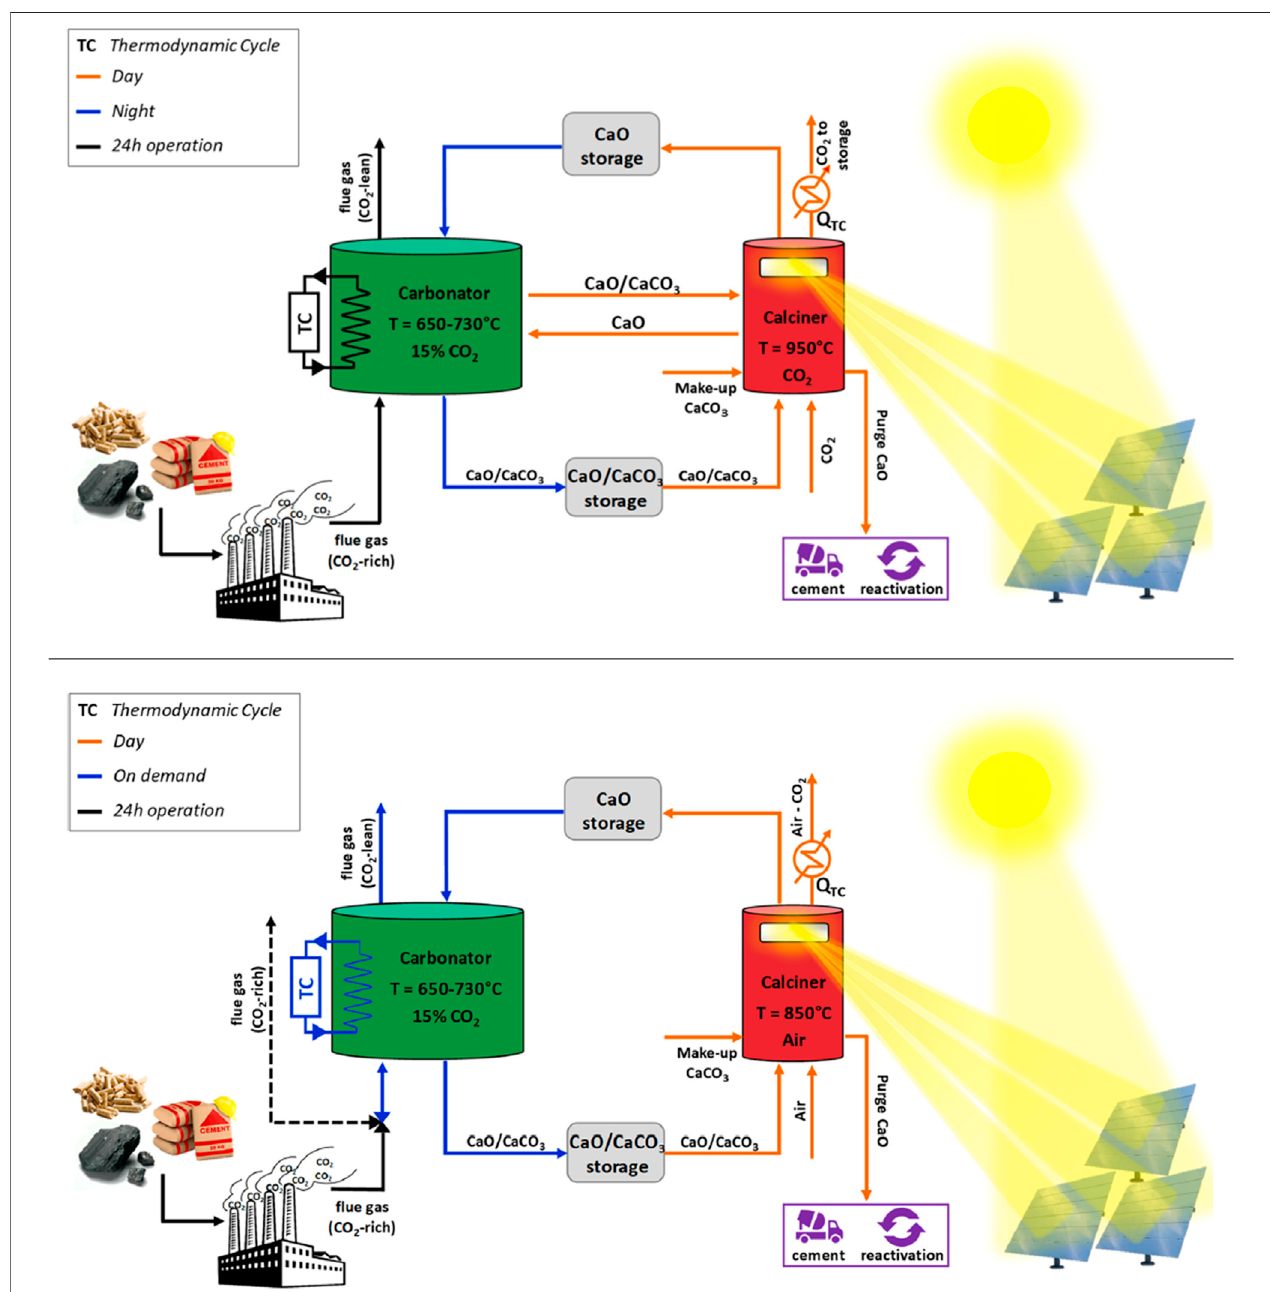
FIGURE 10 | Outline of the integrated CSP-CaL process for CCSU (A) and TCES (B) (reprinted/adapted with permission from Tregambi et al. (2019b). Copyright (2019) American Chemical Society).